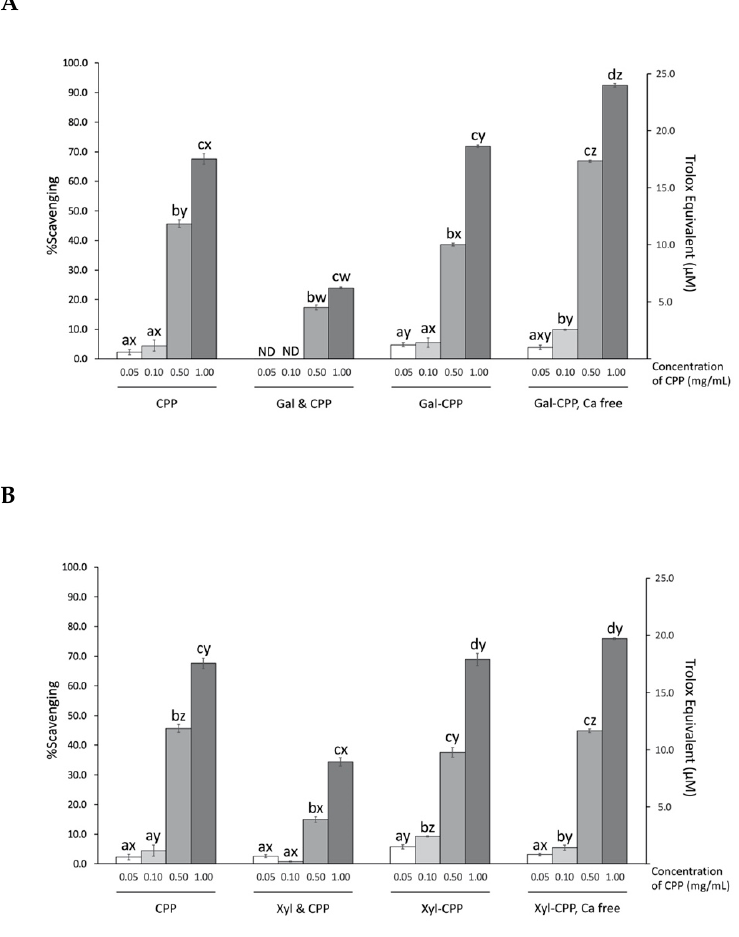
Figure 4. ABTS radical scavenging activity by CPP and CPP–polysaccharide (( A ) Gal; and ( B ) Xyl) conjugates and mixtures. Trolox equivalent was calculated using the standard curve equation y = 3.896x − 0.5844, where x stands for micromolar ( µ M) of Trolox and y for percent scavenging. CPP, casein phosphopeptide; Gal (or Xyl) & CPP, non-conjugated mixtures of galactomannan (or xyloglucan) and CPP; Gal–CPP or Xyl–CPP, conjugates of galactomannan or xyloglucan with CPP